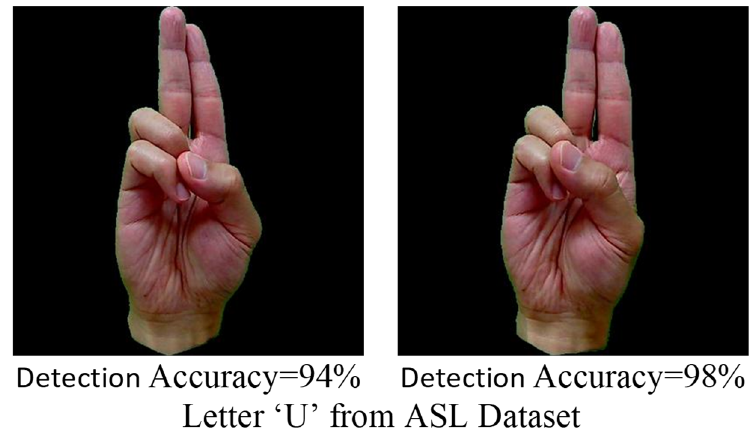
Figure 17. Processing variation in same hand gesture scenario 4.